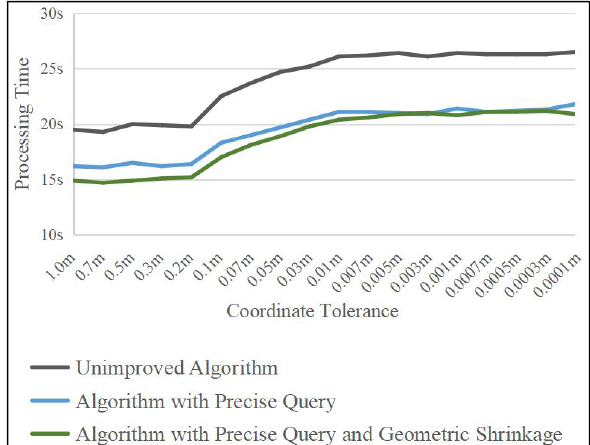
Figure 4. Average processing time comparison of resident